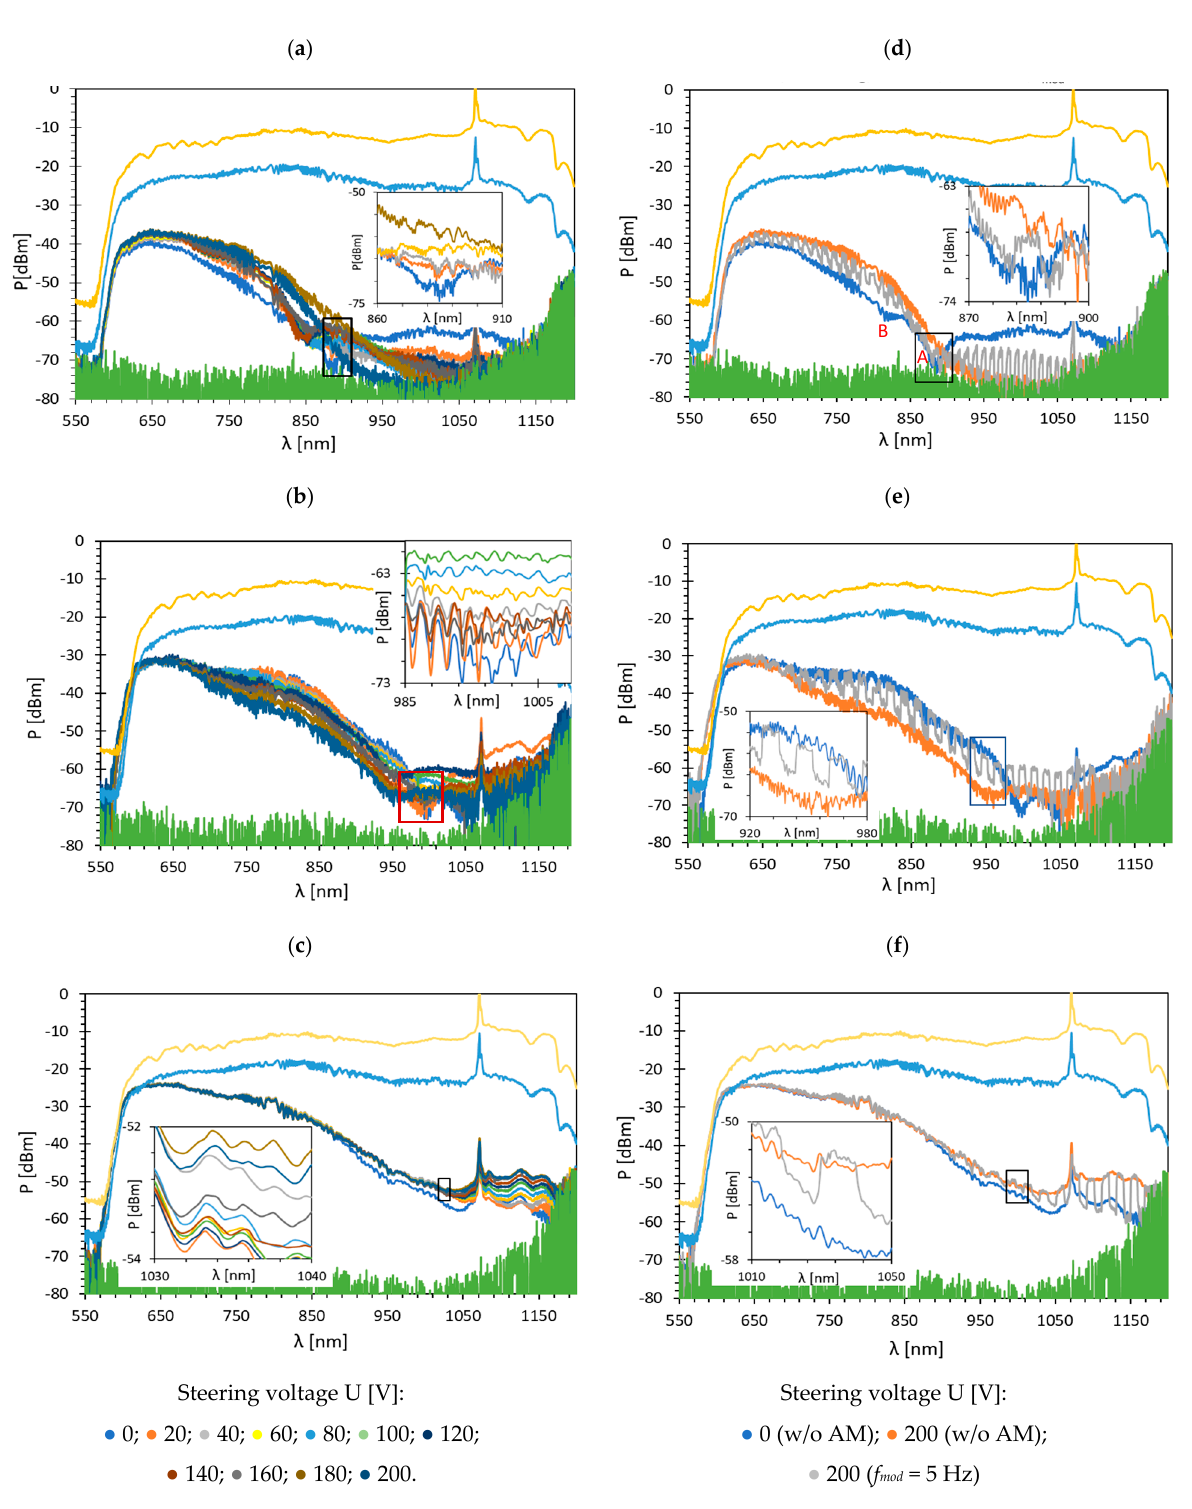
Figure 5. Spectra obtained for TOF with bimetallic Ag/Au layer coating for: ( a ) orthogonal; ( b ) parallel; ( c ) twisted cell under voltage U: 0–200 V w/o AM, and dynamic response of: ( d ) orthogonal; ( e ) parallel; ( f ) twist cell with f mod = 5 Hz with 100% AM. (cid:107) = 996.4 nm, respec- Their resonant wavelengths are equal to λ ⊥ = 886.3 nm and λ res res tively, and they are moved by approximately 214.1 nm relative to the dips obtained for LCC with pure gold and 155 nm relative to the dips obtained for LCC with pure silver. Based